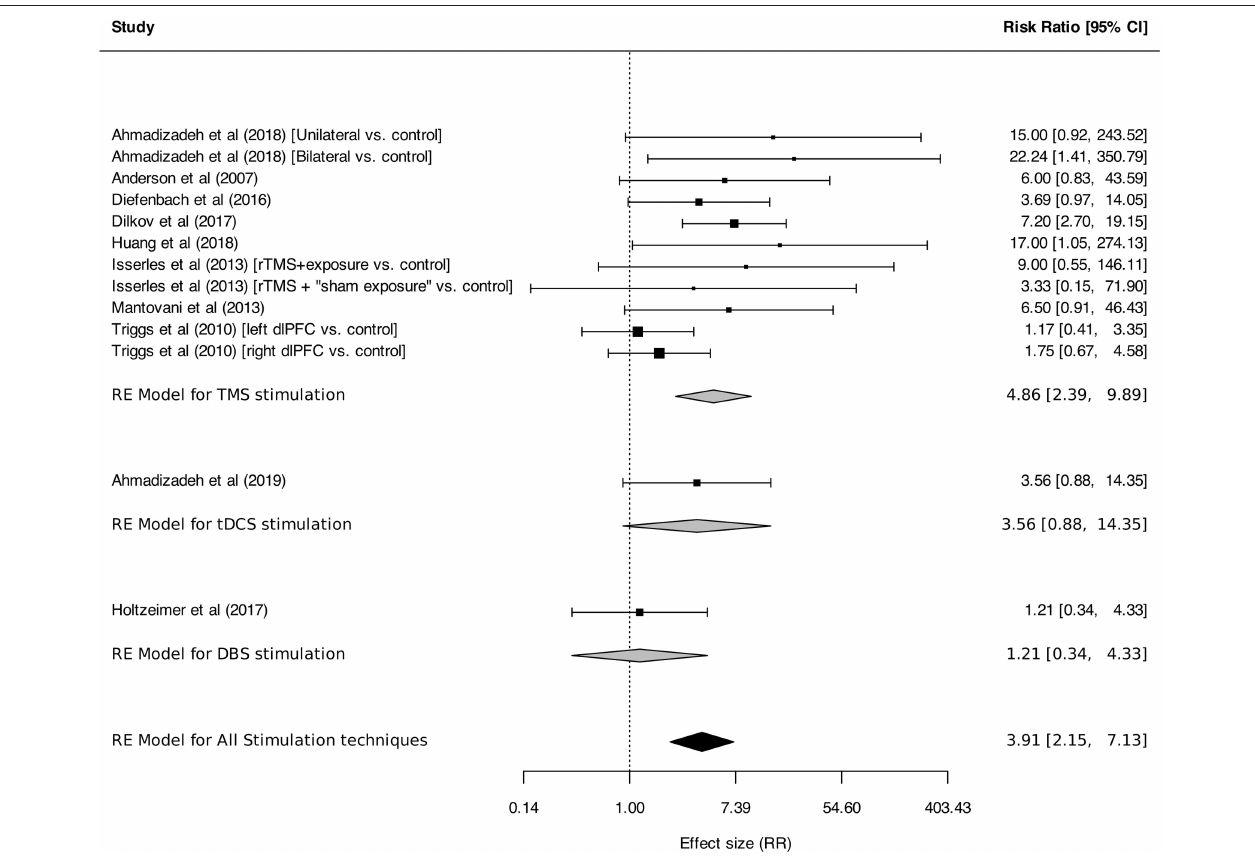
FIGURE 5 | Response rates for anxiety, stressor-related disorders and MDD, subgroups by stimulation technique. Statistics: TMS: heterogeneity Sigma1 2 = 0.42, Sigma2 2 = 0.00, Q(df = 10) = 13.36, p = 0.20; I 2 = 39%; test for overall effect: Z = 4.35 ( p < 0.0001); tDCS: heterogeneity: not applicable. DBS: heterogeneity: not applicable. Total: heterogeneity Sigma1 2 = 0.36, Sigma2 2 = 0.00, Q(df = 12) = 15.84, p = 0.20; I 2 = 37%; test for overall effect: Z = 4.45 ( p < 0.0001); F(df1 = 2, df2 = 22) = 0.05, p =